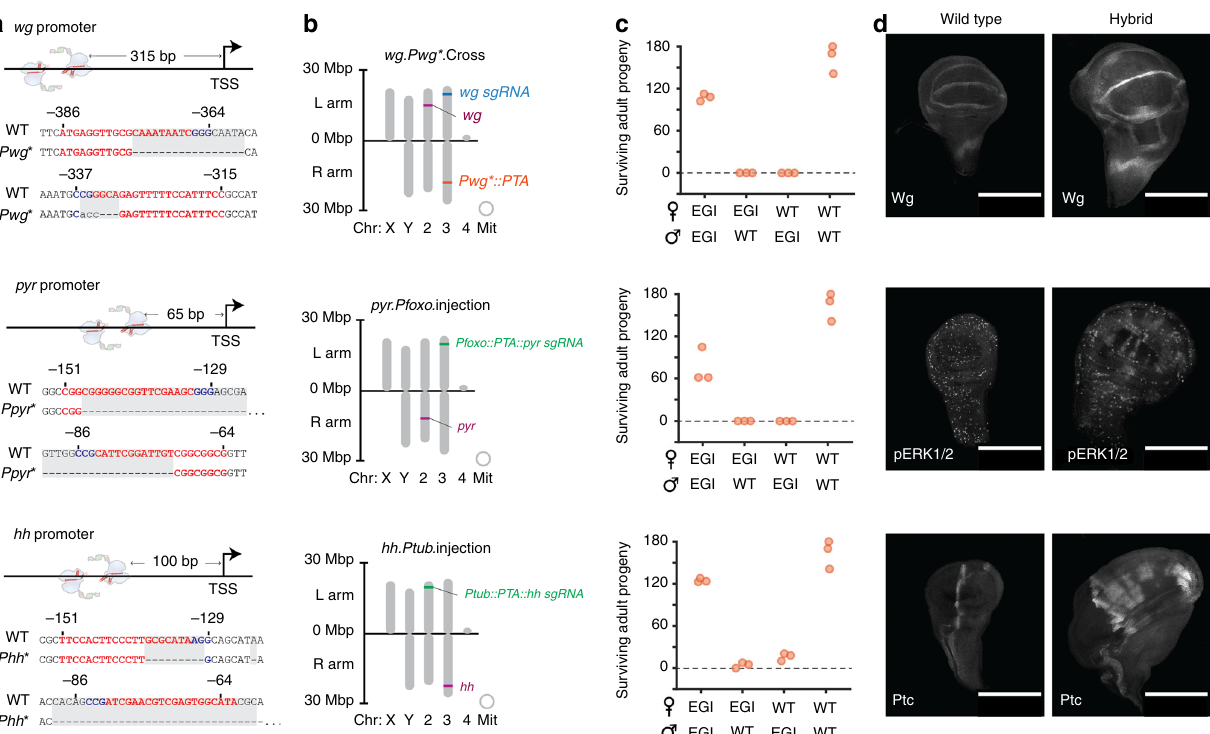
Fig. 3 Genotype and hybrid incompatibility of select EGI strains. a Proximity of sgRNA-binding sites to transcription start site (TSS) for EGI strains. Sequences of both sgRNA-binding sites are shown below promoter illustration, with protospacers in red and protospacer adjacent motifs in blue. Sequences of the mutated promoters at the sgRNA-binding loci are shown below with differences highlighted in gray shadow. b Chromosomal locations of genome alterations. Violet text represents target genes, orange text represents PTA-constructs, blue text represents sgRNA constructs, and green text represents joint PTA-sgRNA constructs. c Hybrid incompatibility data showing number of progeny surviving to adulthood. Genotype of parental strains for each cross are given on the x -axis. n = 3 biologically independent experiments. d Immunohistochemical staining of wild-type (left) or hybrid (right) larva showing over or ectopic expression of targeted signaling pathways. Antibody binding targets are labeled in the bottom left corner of each image. For each panel, the wg-, pyr- , and hh -targeting EGI genotypes are shown from top to bottom. 200 µ M scale bar. Images are representative of at least six independent biological samples for each PTA × sgRNA crosses (yielding pupal lethality instead of larval lethality). We believe that the weaker phenotype for hh -targeting guides in the EGI × wild-type hybrids (i.e. Fig. 3) versus the PTA